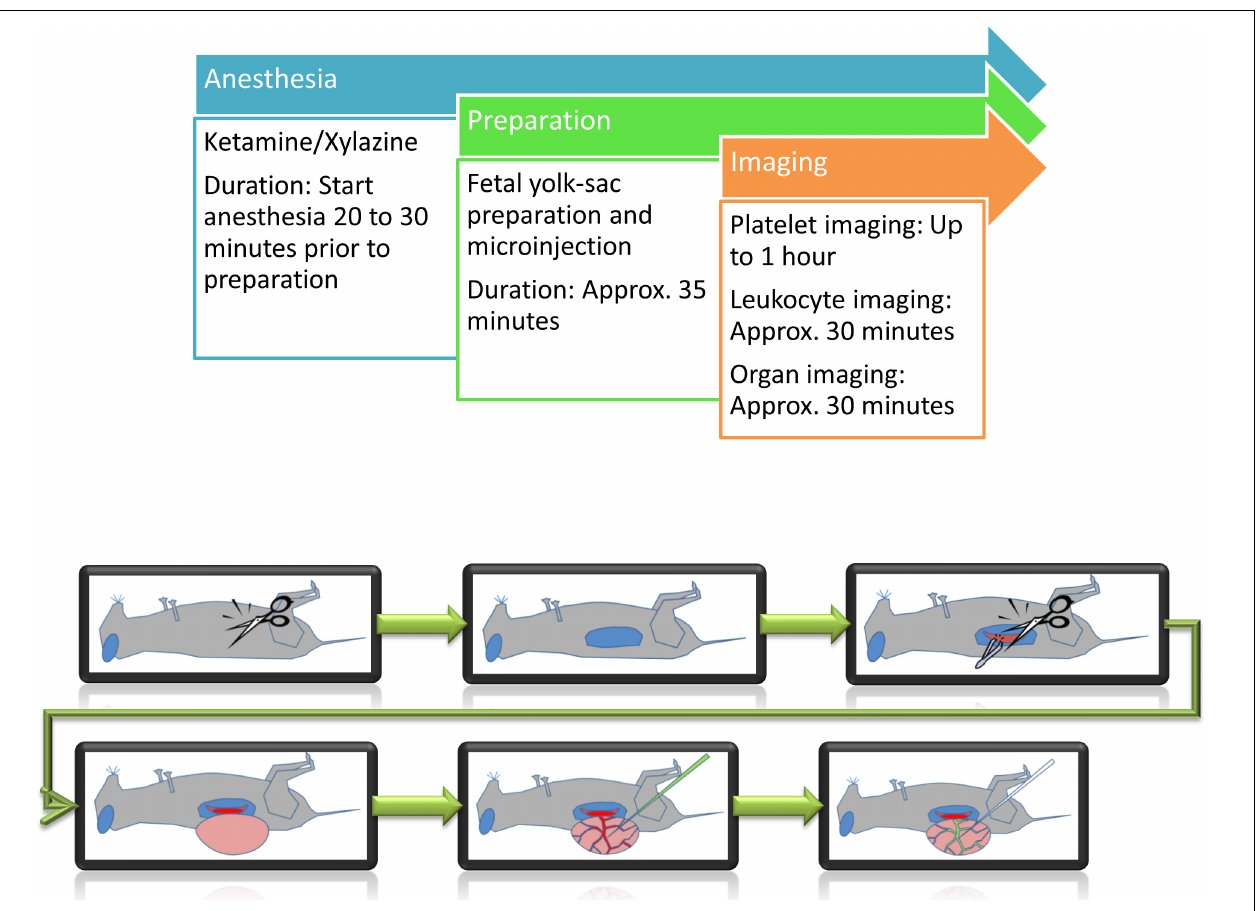
FIGURE 1 | Schematic representation of preparation steps for fetal in vivo imaging. Following anesthesia, the yolk-sac is prepared for imaging and/or microinjection.